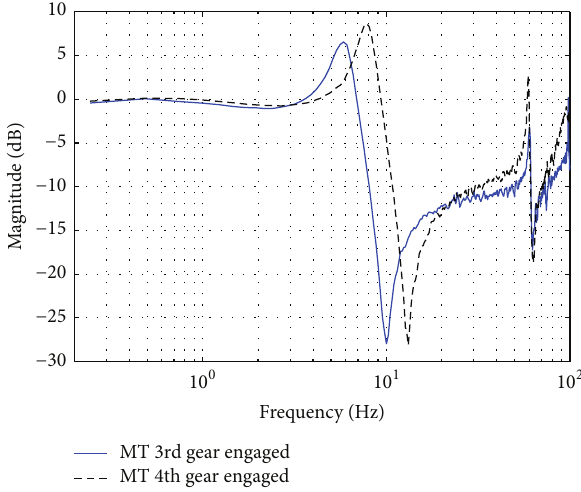
Figure 15: Effect of the gear ratio on the modulus of the FRF 𝑇 𝑇 fb ,5 / ref ,5 .